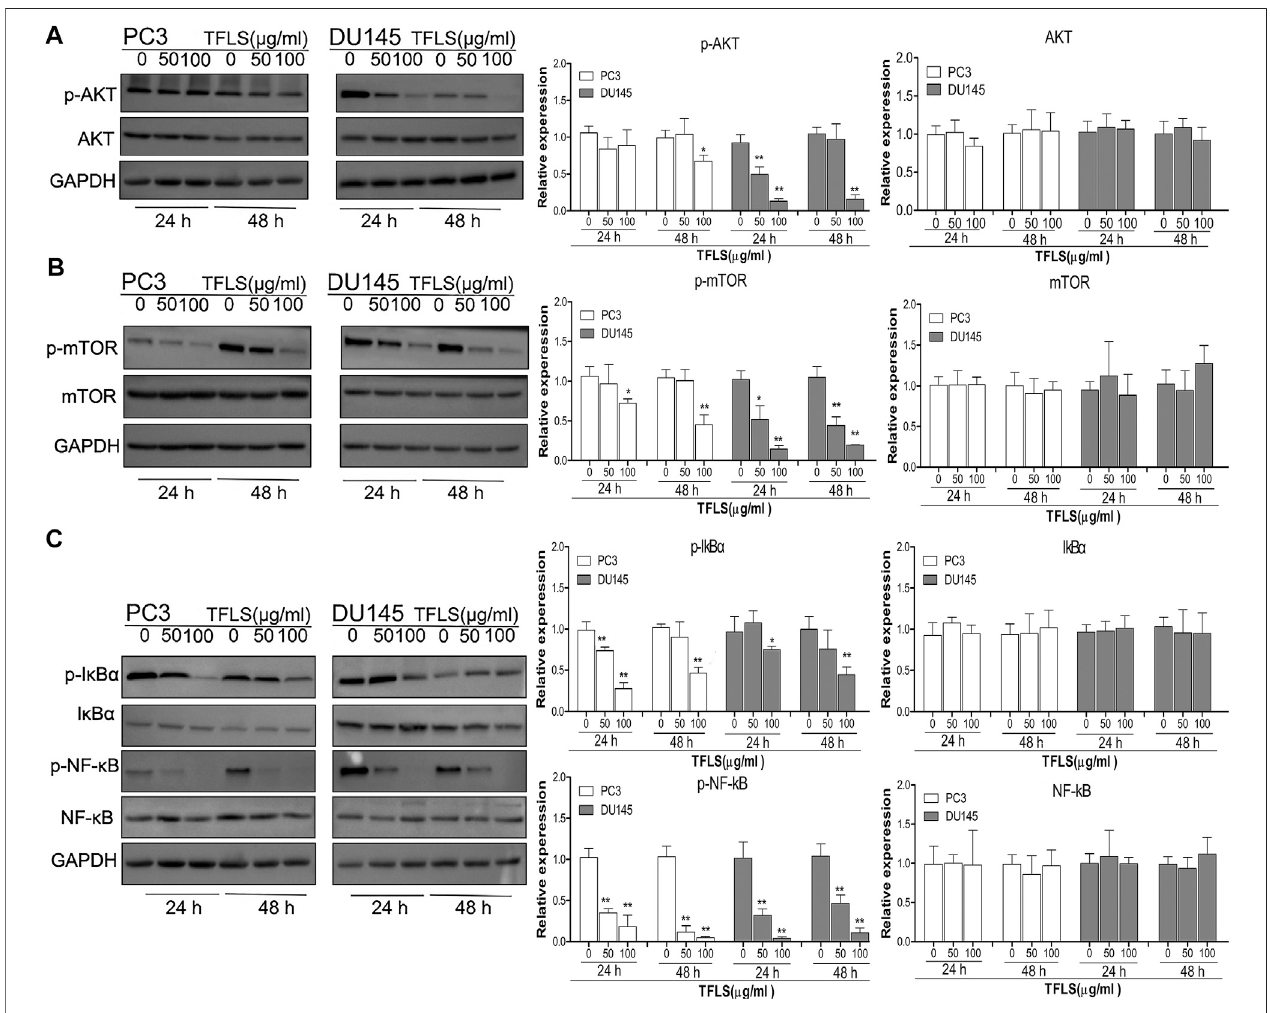
FIGURE 7 | TFLS inhibited the AKT/mTOR and NF- κ B signaling pathways in PCa cells. PC3 and DU145 cells were treated with TFLS, the expression of key proteins in AKT pathway (A) , mTOR (B) , NF- κ B (C) signaling pathways was analyzed by Western blot. GAPDH was used as a control. Data are expressed as mean ± SEM, compared with the control group: * p < 0.05; ** p <